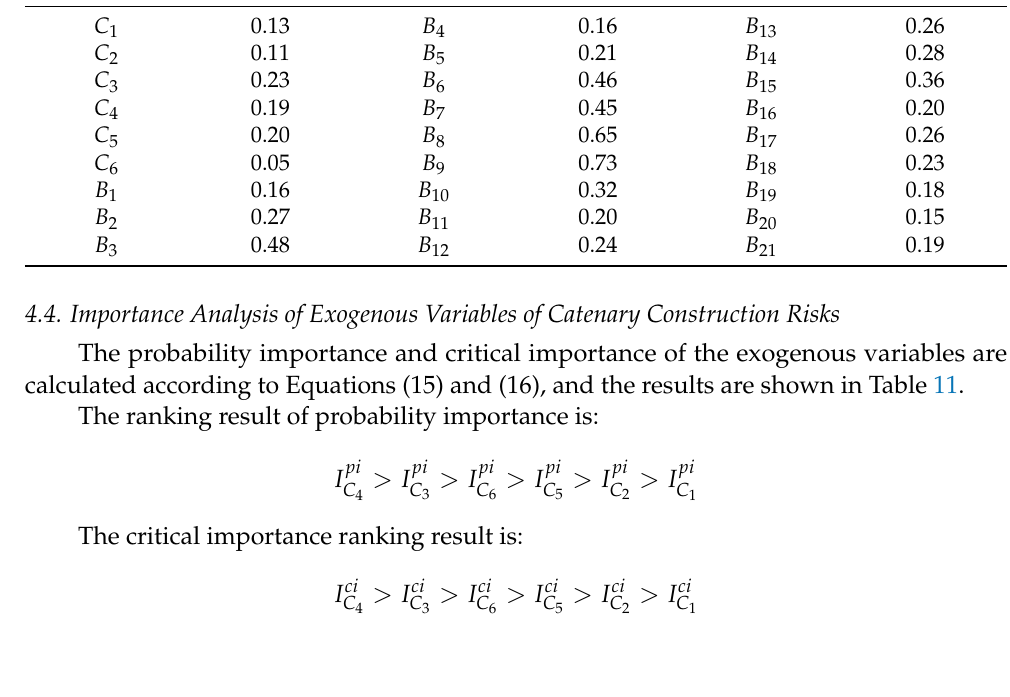
Figure 6. Analysis diagram of catenary construction risks Bayesian network reverse inference.